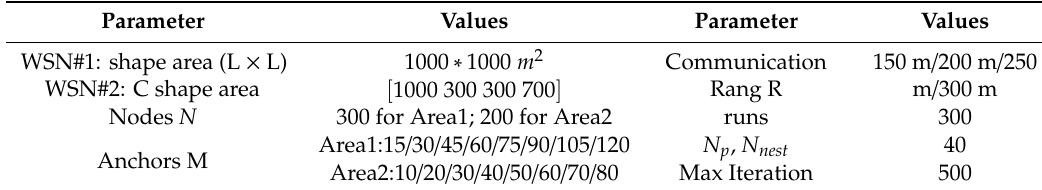
Figure 4. Illustration of deployment for WSN#2. Table 1. Simulation Parameters.